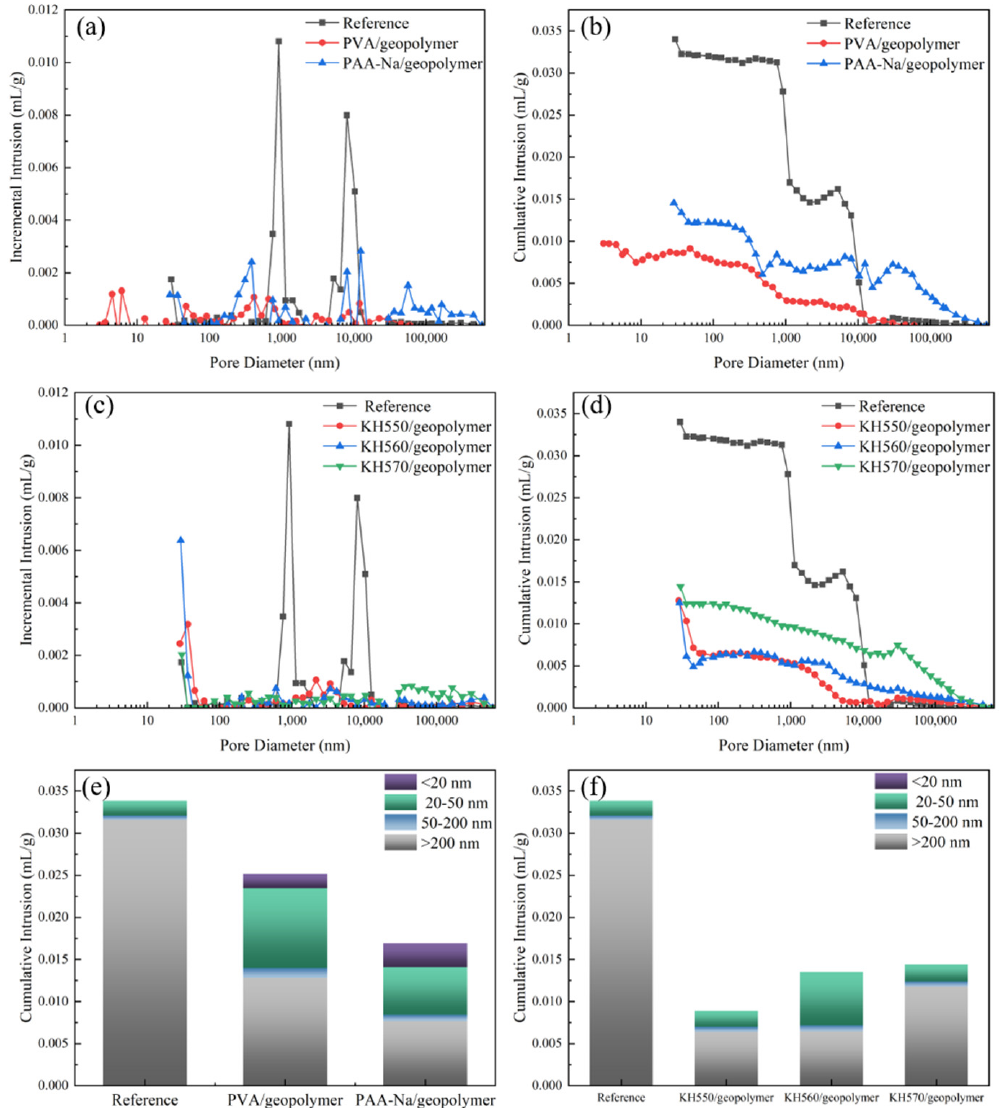
Figure 7. Porosity ( a , c ), pore size distribution ( b , d ) and pore volume distribution ( e , f ) of organic– inorganic composite geopolymer slurry.